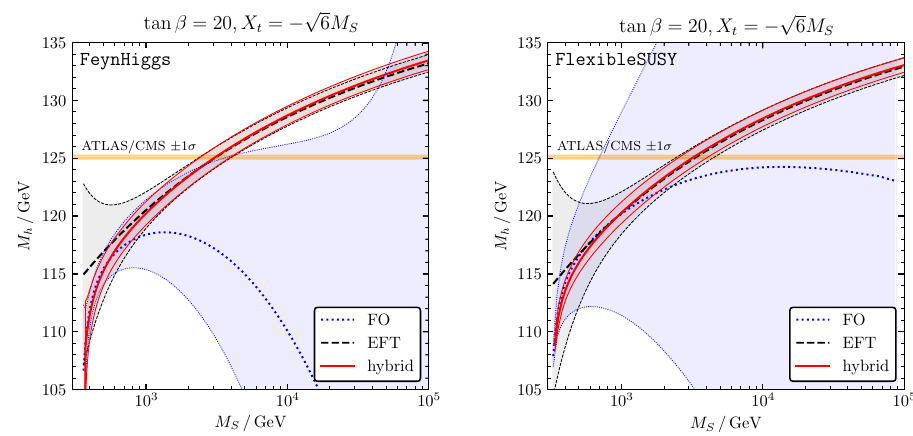
Fig. 5 Comparison between the pure FO, pure EFT and hybrid calculations of the Higgs mass, with the corresponding estimates of the theory uncertainty, in an MSSM scenario with degenerate SUSY masses. The sfermion mass and mixing parameters are defined in the DR scheme at the scale Q = M S . The left plot is produced with FeynHiggs , the right one with different modules of